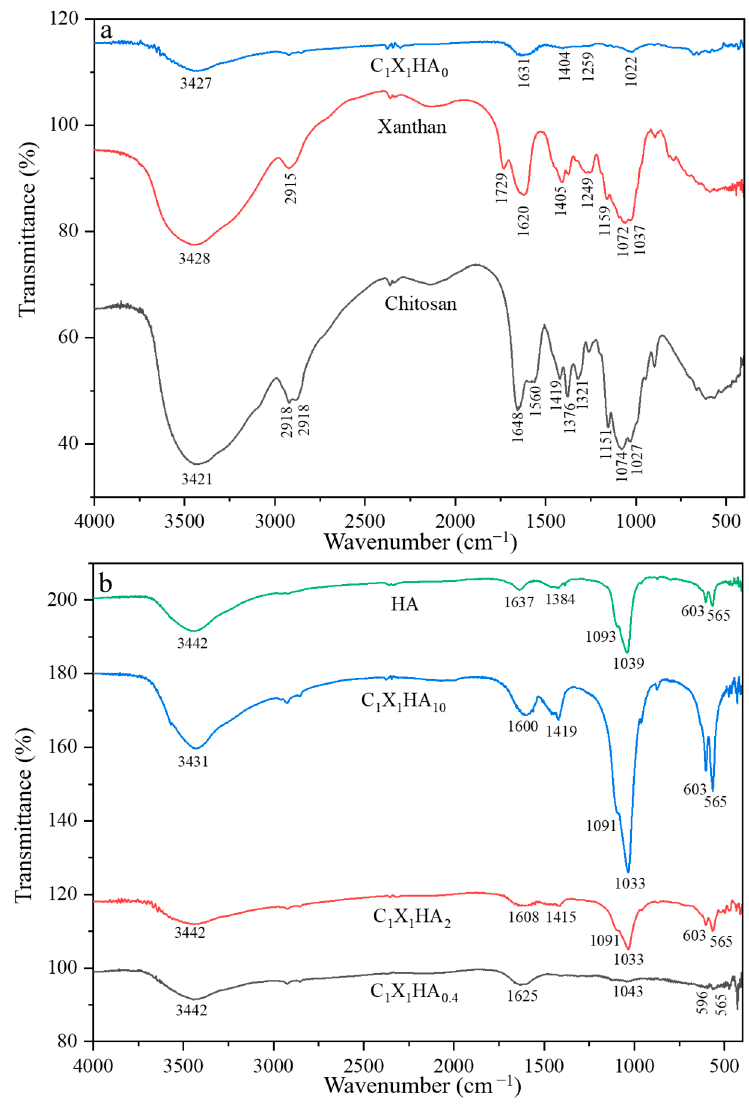
Figure 2. Fourier transform infrared spectra obtained for: ( a ) the chitosan-xanthan membrane without hydroxyapatite (C 1 X 1 HA 0 ) and the pristine polysaccharides chitosan and xanthan gum, and ( b ) chitosan-xanthan membrane formulations incorporating HA at different concentrations and pristine